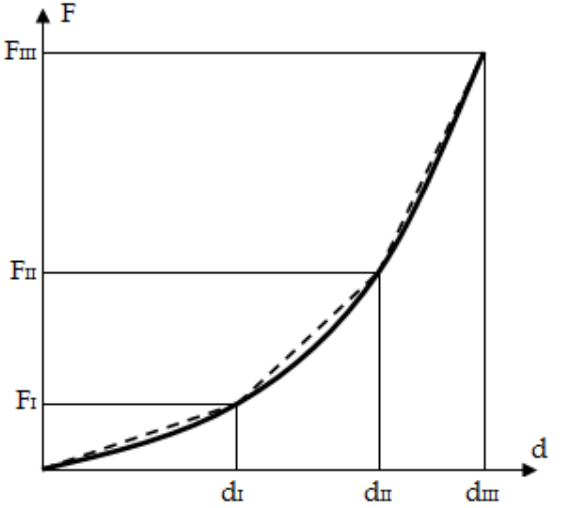
Figure 7. Three-step linearization of a nonlinear elastic characteristic.